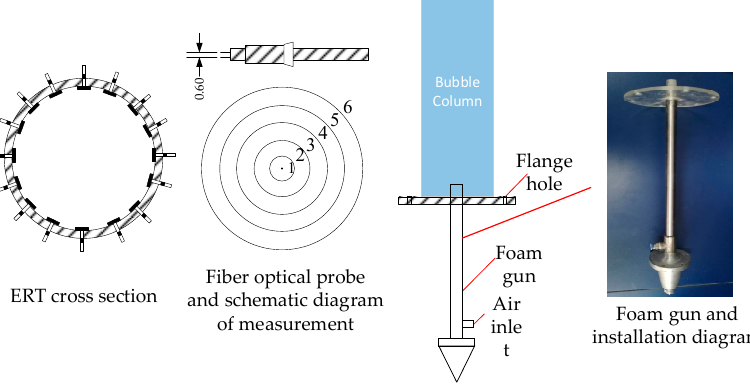
Figure 2. Measuring principle and installation method.